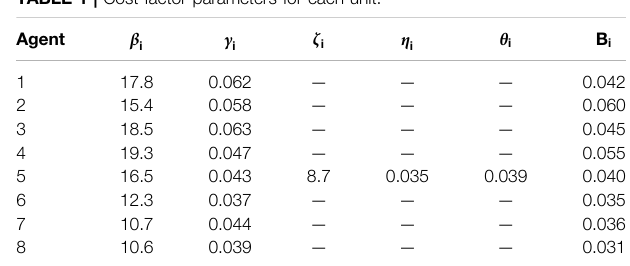
TABLE 1 | Cost factor parameters for each unit.